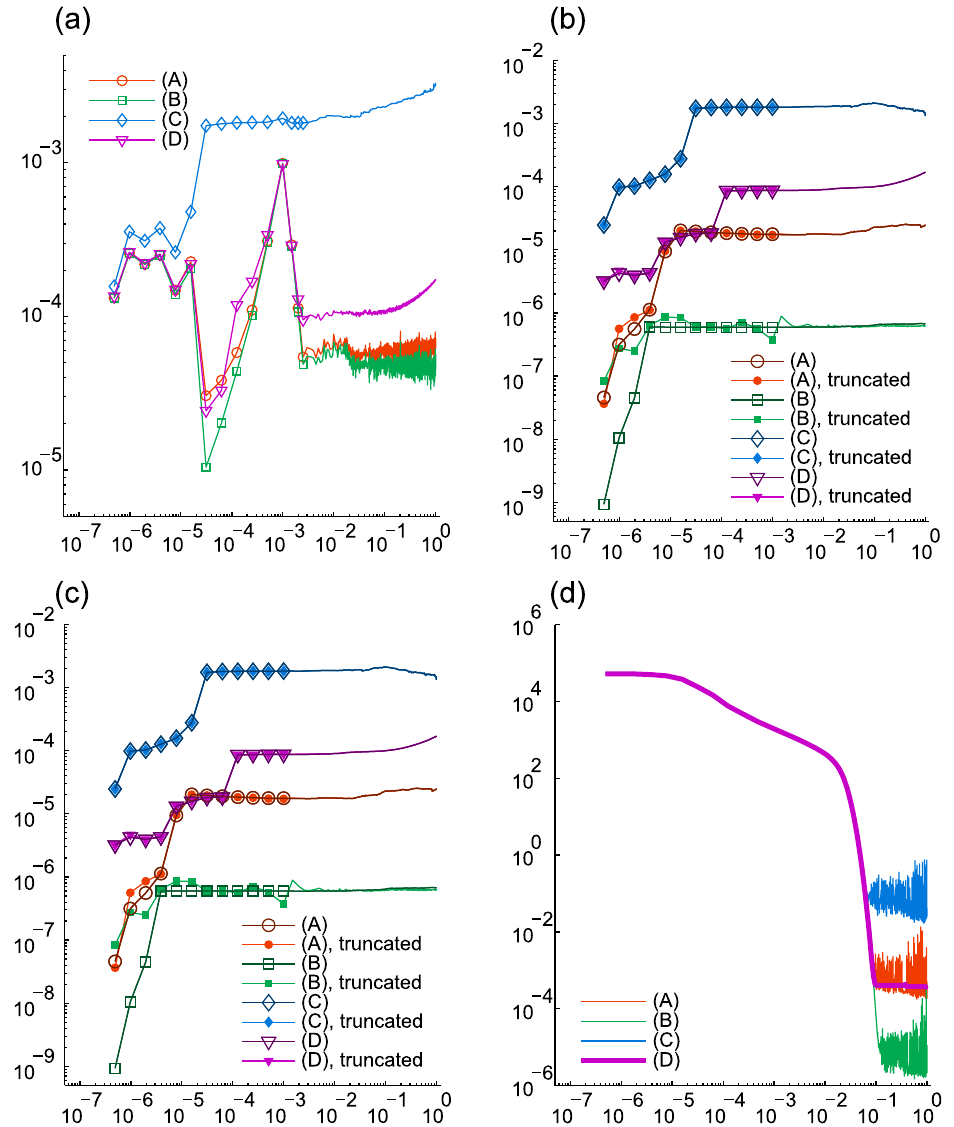
(before truncation) 1